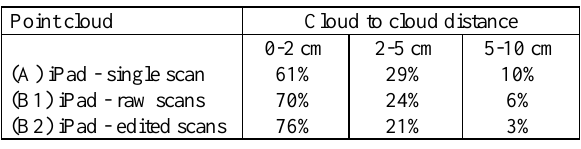
Table 8 . Evaluation of the positioning through ICP algorithm to the TLS scans by means of cloud-to-cloud distance without considering portion where gross errors appeared in the previous